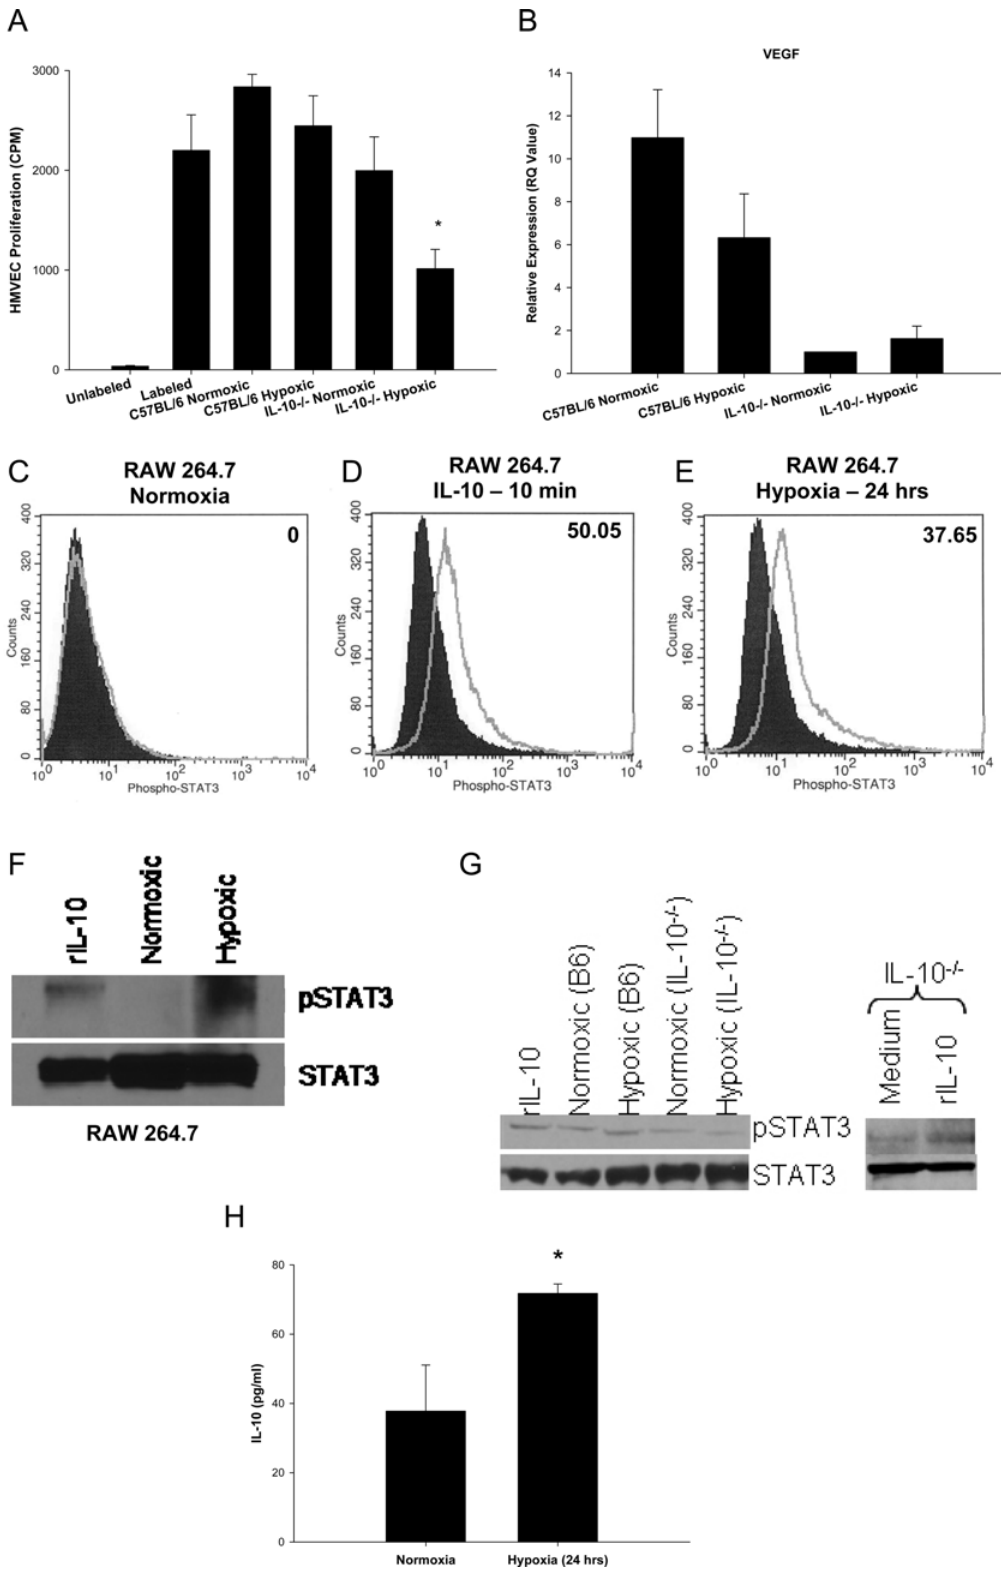
Figure 4. Macrophage responses to hypoxia . Splenic F4/80 + macrophages from IL-10 2 / 2 mice (A) significantly inhibit (*P=0.0163) the proliferation of HMVECs following exposure to hypoxia compared to hypoxia-treated wild-type macrophages. Splenic F4/80 + macrophages from wild-type mice do not significantly (P . 0.05) inhibit HMVEC proliferation compared to untreated HMVECs. This could be due to (B) increased expression of VEGF in wild-type macrophages compared to IL-10 2 / 2 macrophages. The IL-10 signaling pathway appears to be activated following